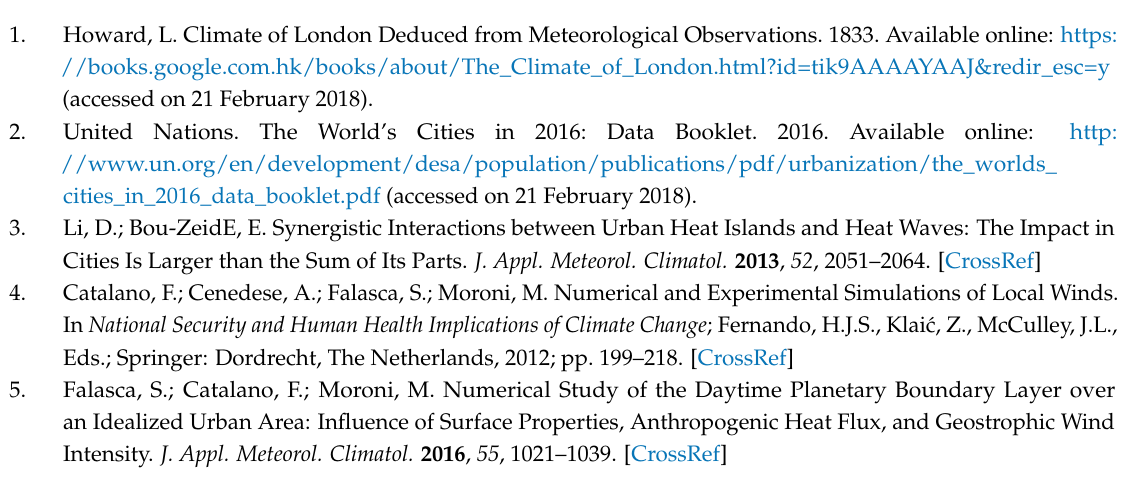
Figure S2: daily cycles of the PM25 concentration ( µ g/m 3 ) averaged over the simulation period (14–23 July 2014) for the Reference case (blue line), the test case with highly-reflective roofs coverage (AlbRoof , red line) and the test case with highly-reflective coverage for roofs, walls and roads (AlbAll, green line), Figure S3: difference of average PM25 concentration between tests using highly reflective materials and the reference case at 00:00 LT and at 12:00 LT, Figure S4: same as Figure S2, but for NO 2 concentration, Figure S5: same as Figure S3, but for NO 2 , Table S1: statistical summary of model to observation comparison for temperature at 2 m height and wind speed at 10 m height for test using different urban canopy models and referring to July 2010. Indices are defined below (Falasca and Curci, under review), Table S2: same as Table S1, but for ozone in July 2010 and PM10 in January 2010 (Falasca and Curci, under